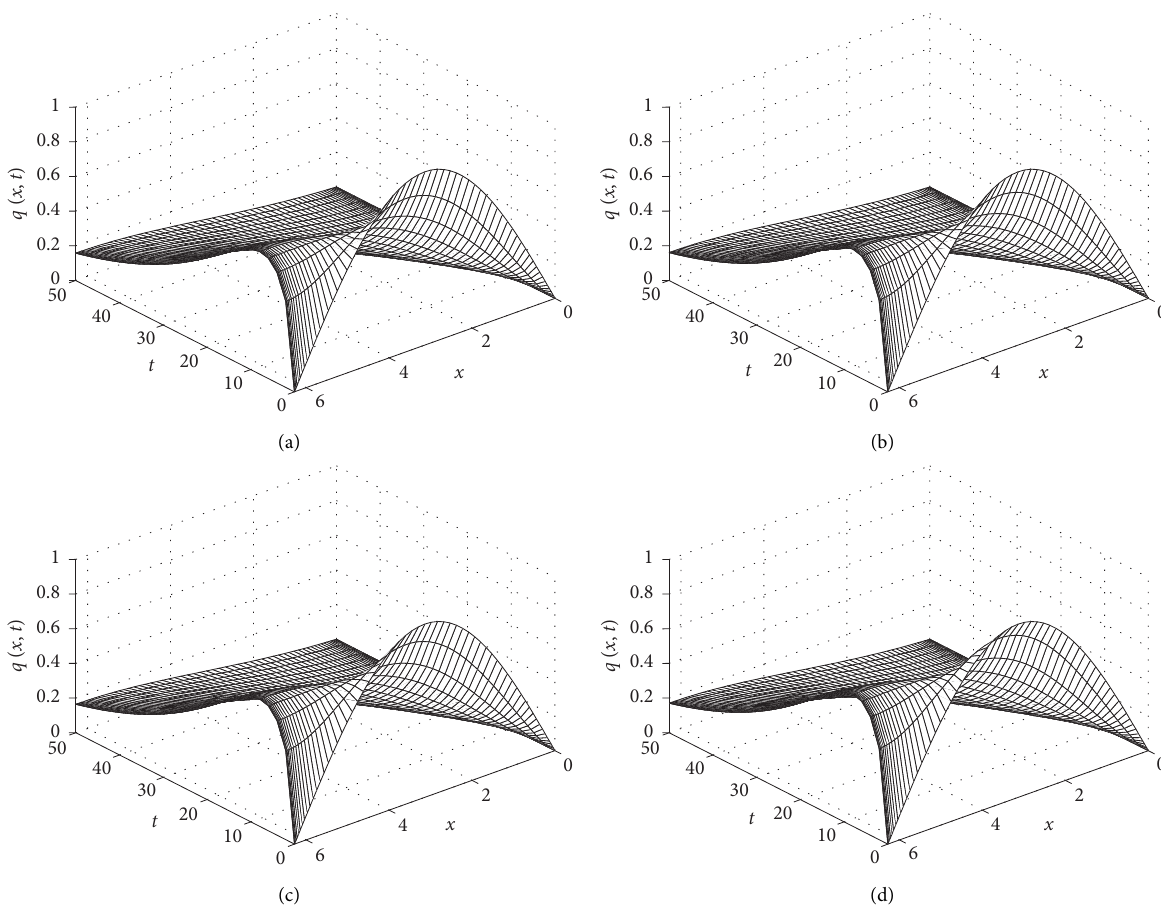
Figure 1: Time evolution of q ( x, t ) in (14) with the spatial distribution function b ( x ) � x / π − 1, q ( x, s ) � ( 1 + s ) sin ( x /2 ) , α � 0 . 4 , β � 0 . 1 , κ � 0 . 02, and for different values of τ : (a) τ � 0 . 02; (b) τ � 0 . 04; (c) τ � 0 . 06; (d) τ � 0 .